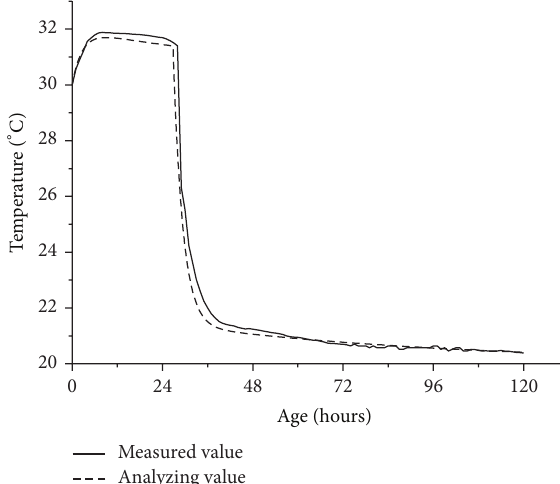
Figure 7: Predicting temperature development at Point